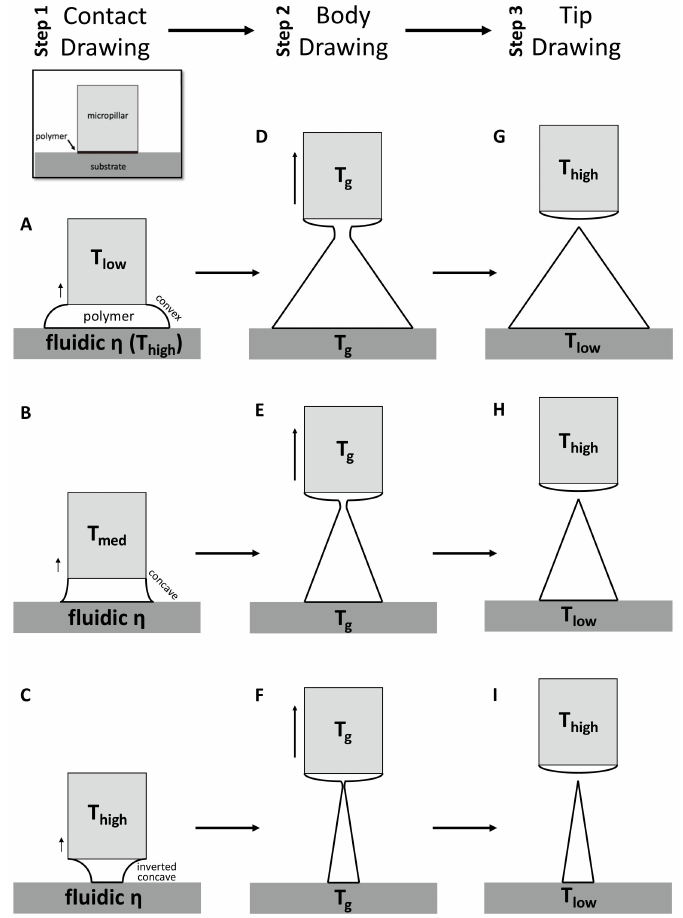
Figure 2. Schematic diagram of three-step thermal drawing process. Contact drawing ( A – C ) determinates the aspect ratio (A/R) of microneedle (MN). Body drawing ( D – F ) determinates the A/R and height of MN. Tip drawing ( G – I ) sharpen the apex tip of